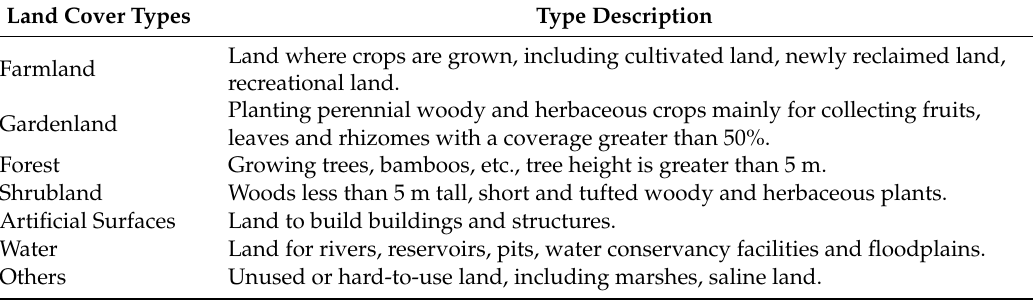
Table 2. Classification system reference